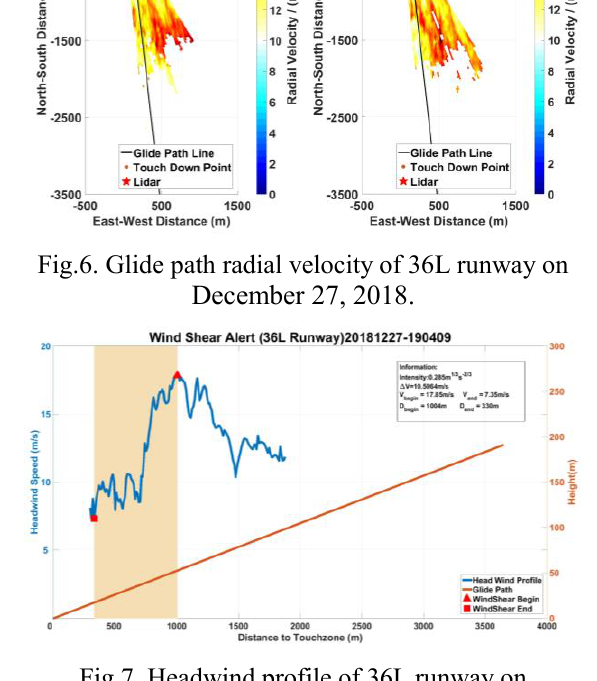
Fig.7. Headwind profile of 36L runway on December 27,